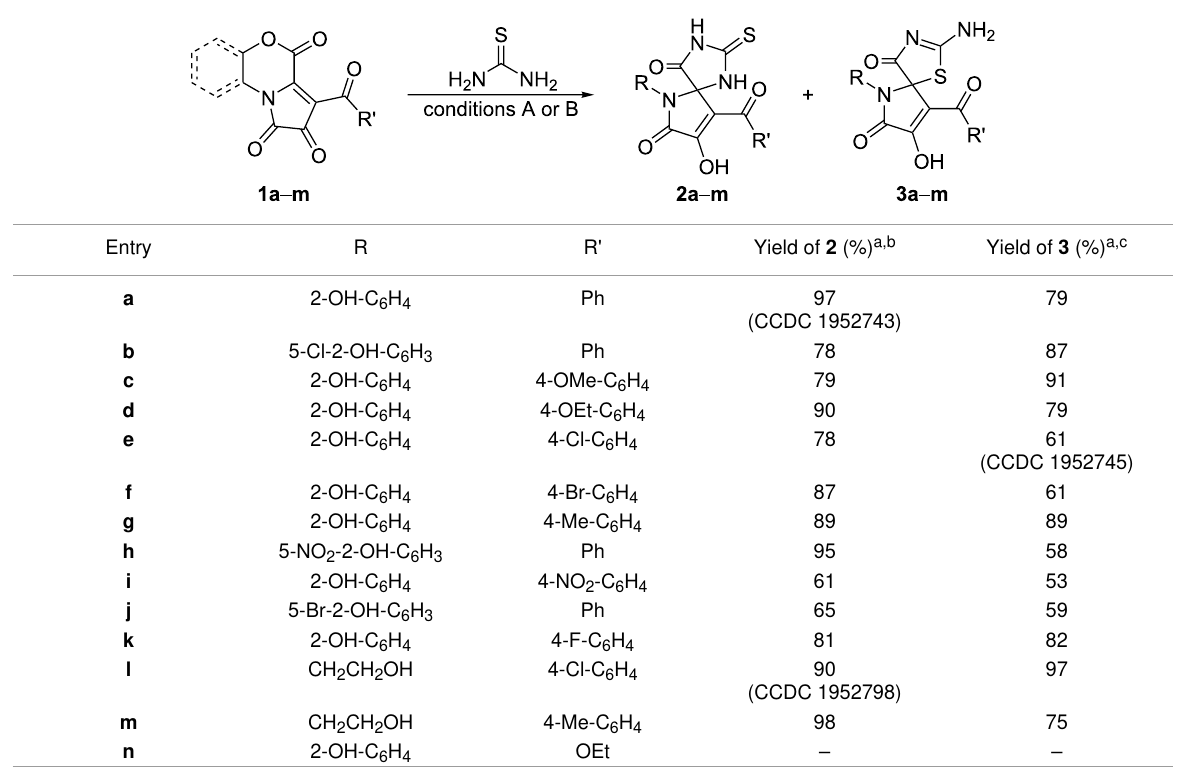
Table 3: Series of spiro-fused thiohydantoins 2a – m and pseudothiohydantoins 3a – m from various FPDs 1a – n